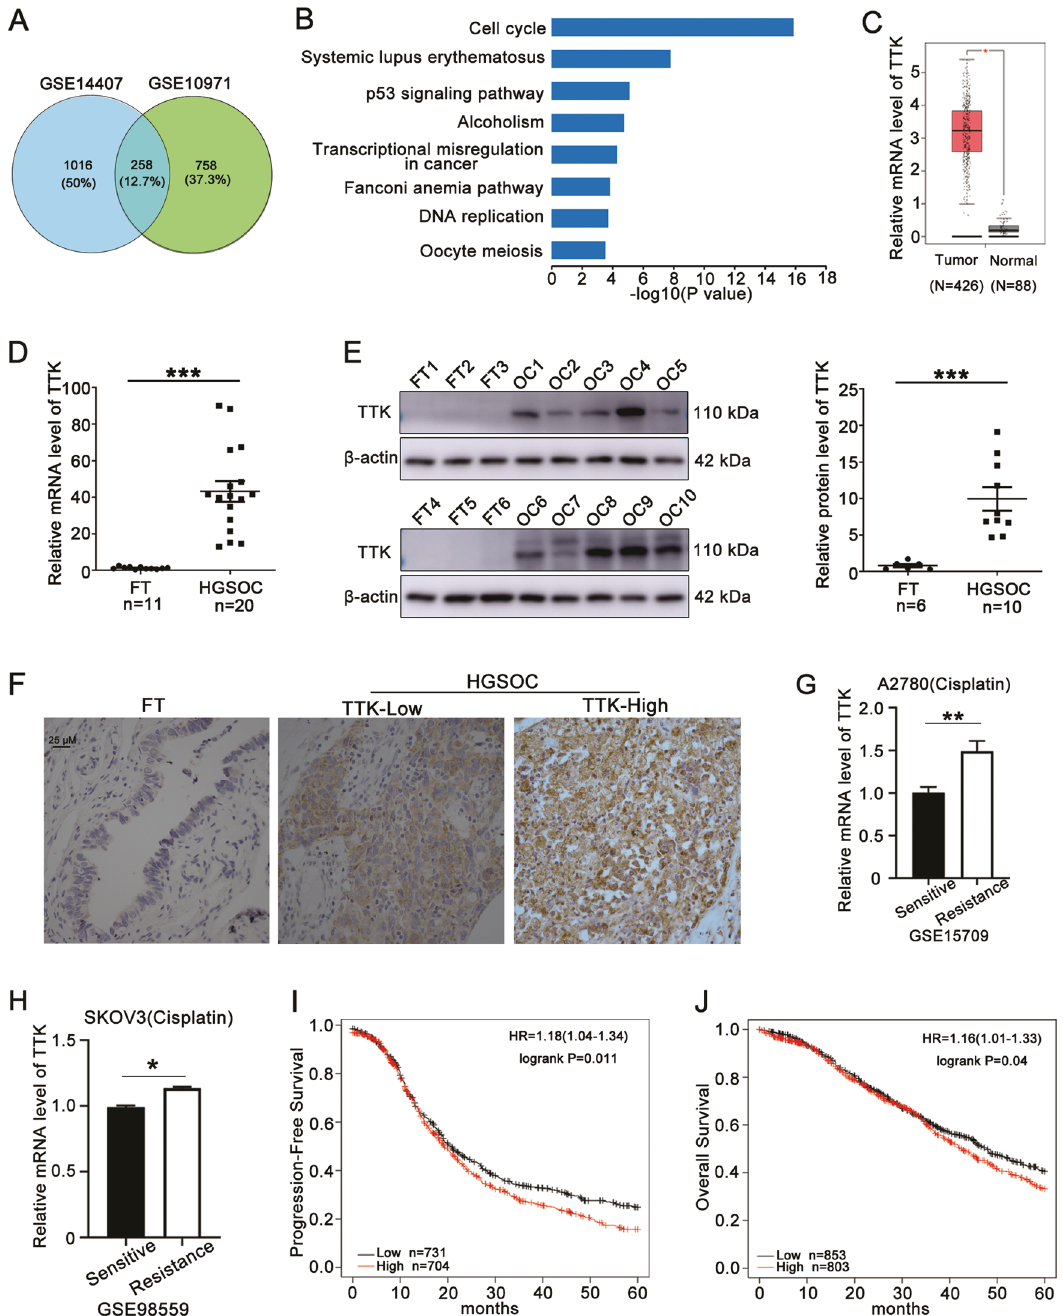
P < 0.001). B The KEGG pathway analysis of overlapping genes in ( A ). C The mRNA expression of TTK in ovarian cancer ( n = 426) and normal control tissues ( n = 88) from the GEPIA database. D RT – qPCR analysis showing the TTK mRNA level in HGSOC and the comparison to FT tissues (FT, n = 11; HGSOC, n = 20). E The level of the TTK protein in HGSOC and FT tissues was detected using western blot assays (FT, FT1-FT6; HGSOC, OC1-OC10). F Representative IHC images of TTK staining in HGSOC and FT tissues (×400), scale bar: 25 µm. G , H The TTK mRNA level